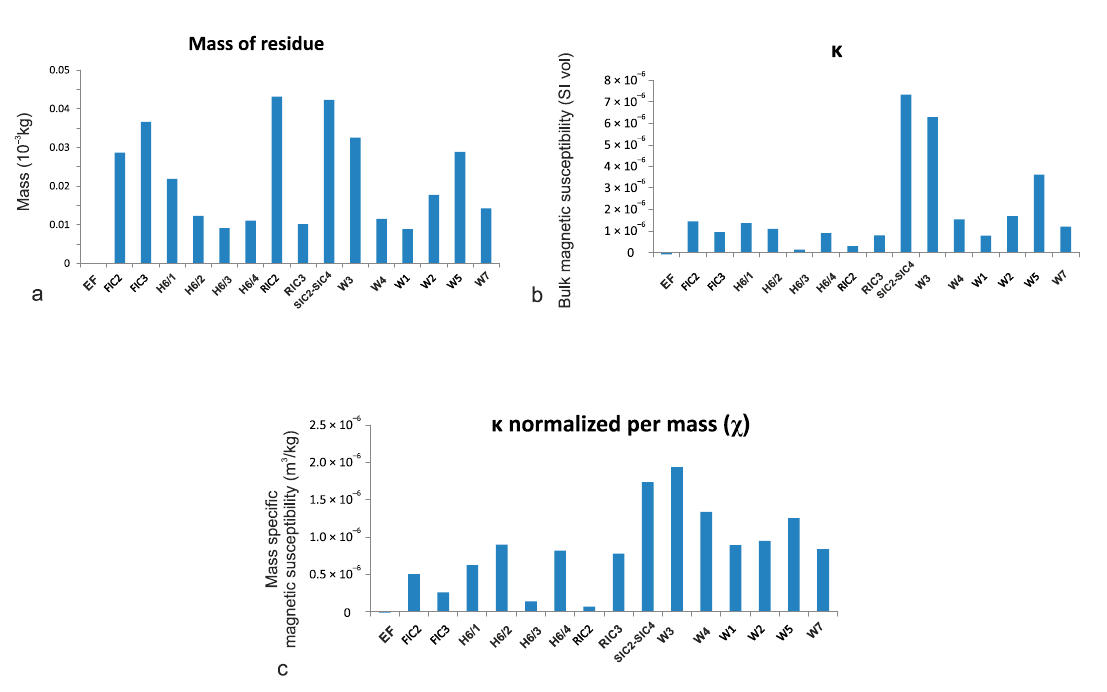
Figure 9. ( a ) Mass of residues collected on filters (see Table 2 for sample details). ( b ) Bulk magnetic susceptibility κ for residues. ( c ) Mass specific susceptibility χ (m 3 / kg); EF—empty filter.